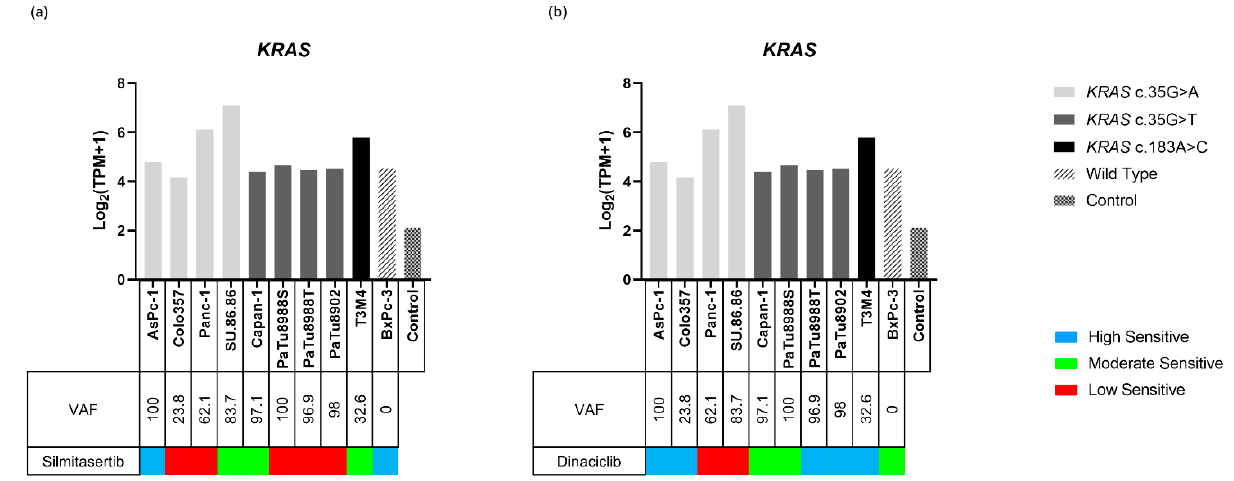
Figure 5. Gene expression of KRAS in ten PDAC cell lines and the control. The sensitivity to silmitasertib ( a ) and dinaciclib ( b ) as well as the variants of KRAS are indicated for each cell lines. Gene expression levels are displayed as Log 2 (TPM+1).